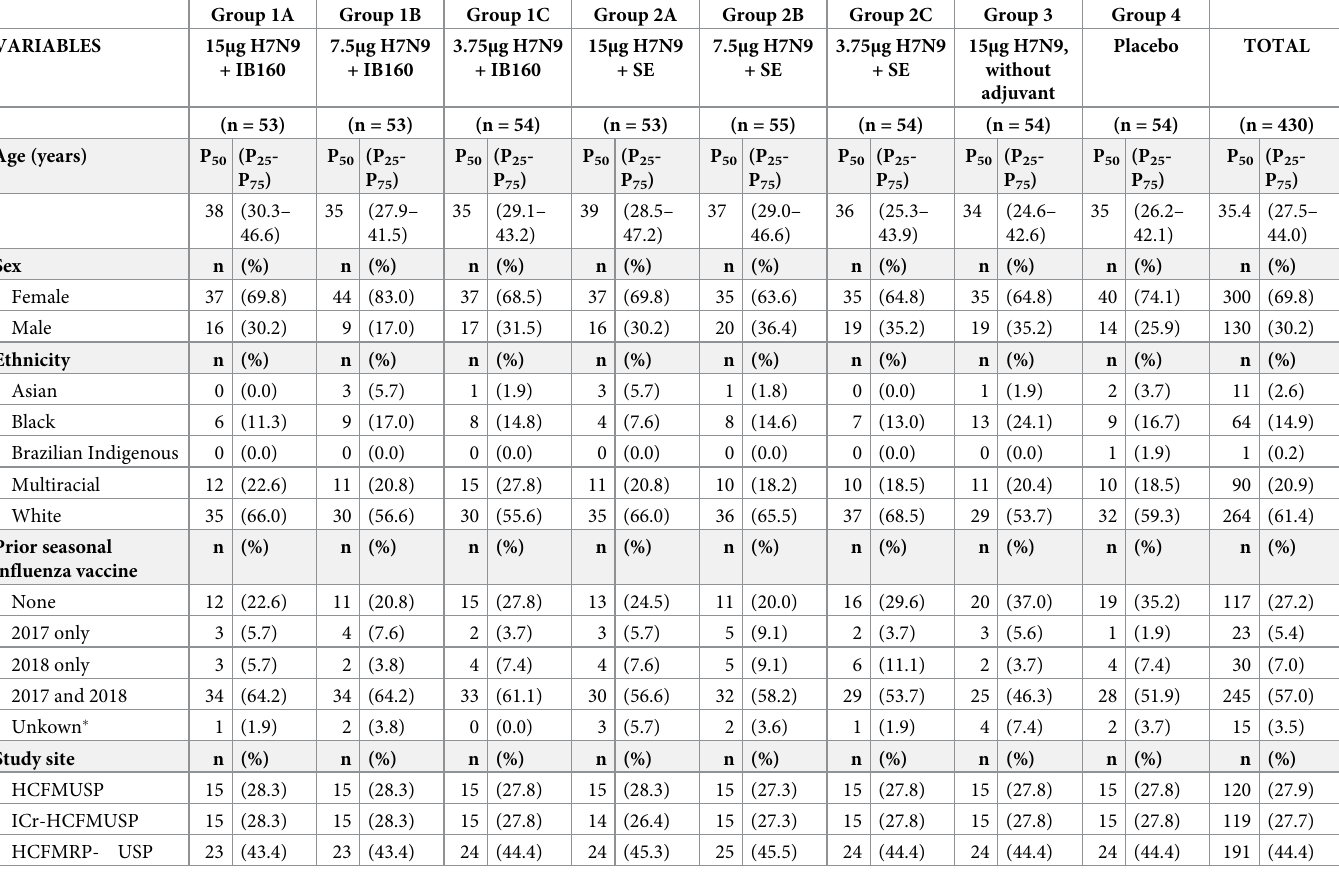
Table 1. Demographic characteristics, prior seasonal influenza vaccine, and study site, by study